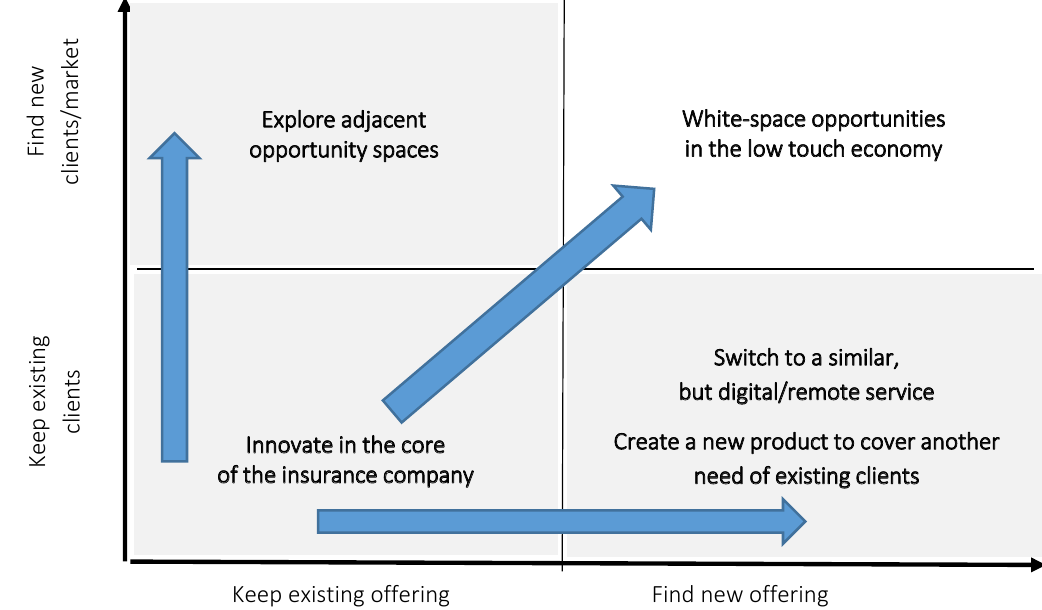
Figure 7. Opportunities for insurer carriers to adopt and pivot in the low-touch economy